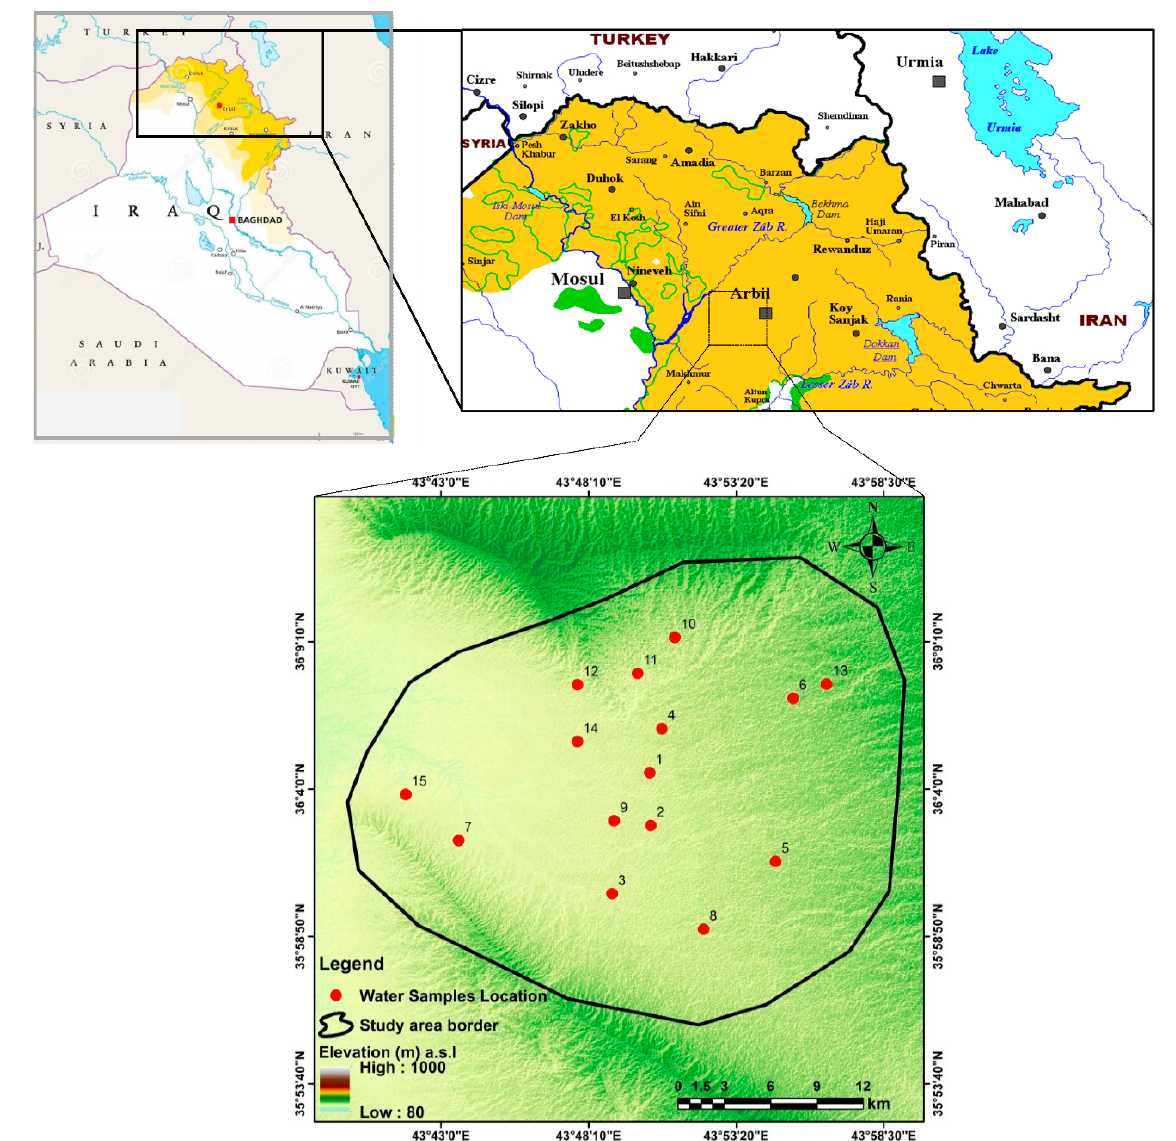
Figure 1. Location map of the study area with water well sample locations .